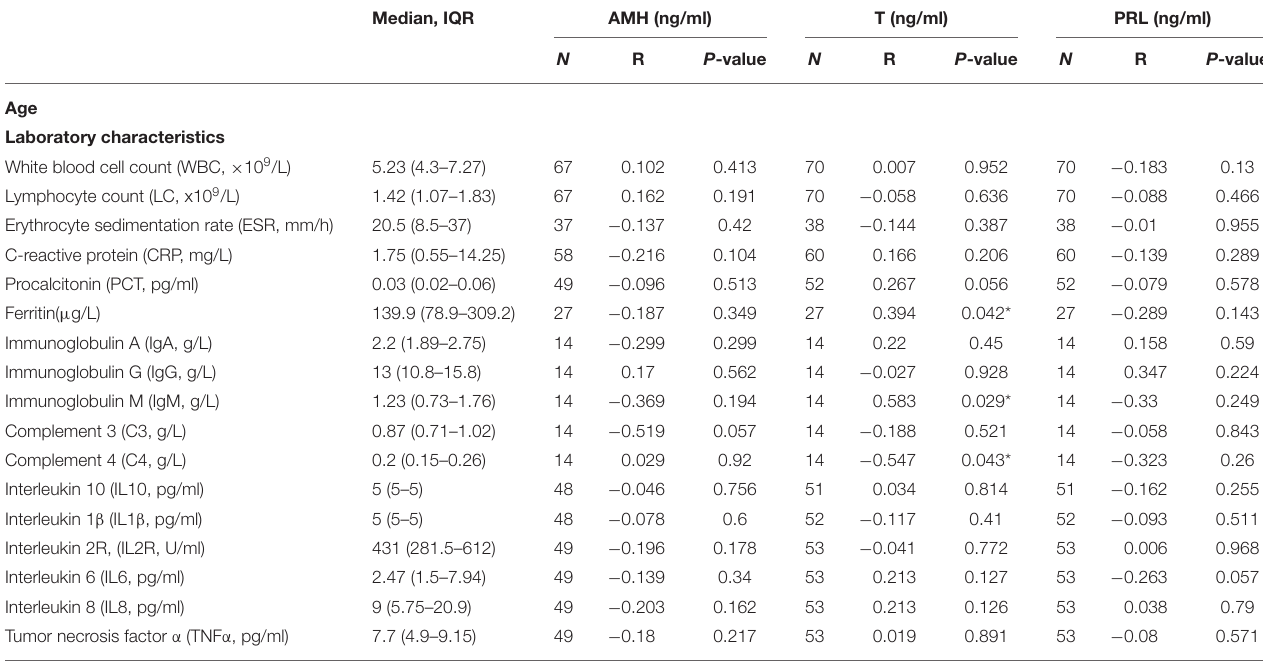
TABLE 5 | The laboratory characteristics of COVID-19 women and their associations with ovarian reserve and sex hormones. Median, IQR AMH (ng/ml) T (ng/ml) PRL (ng/ml) N R P -value N R P -value N R P